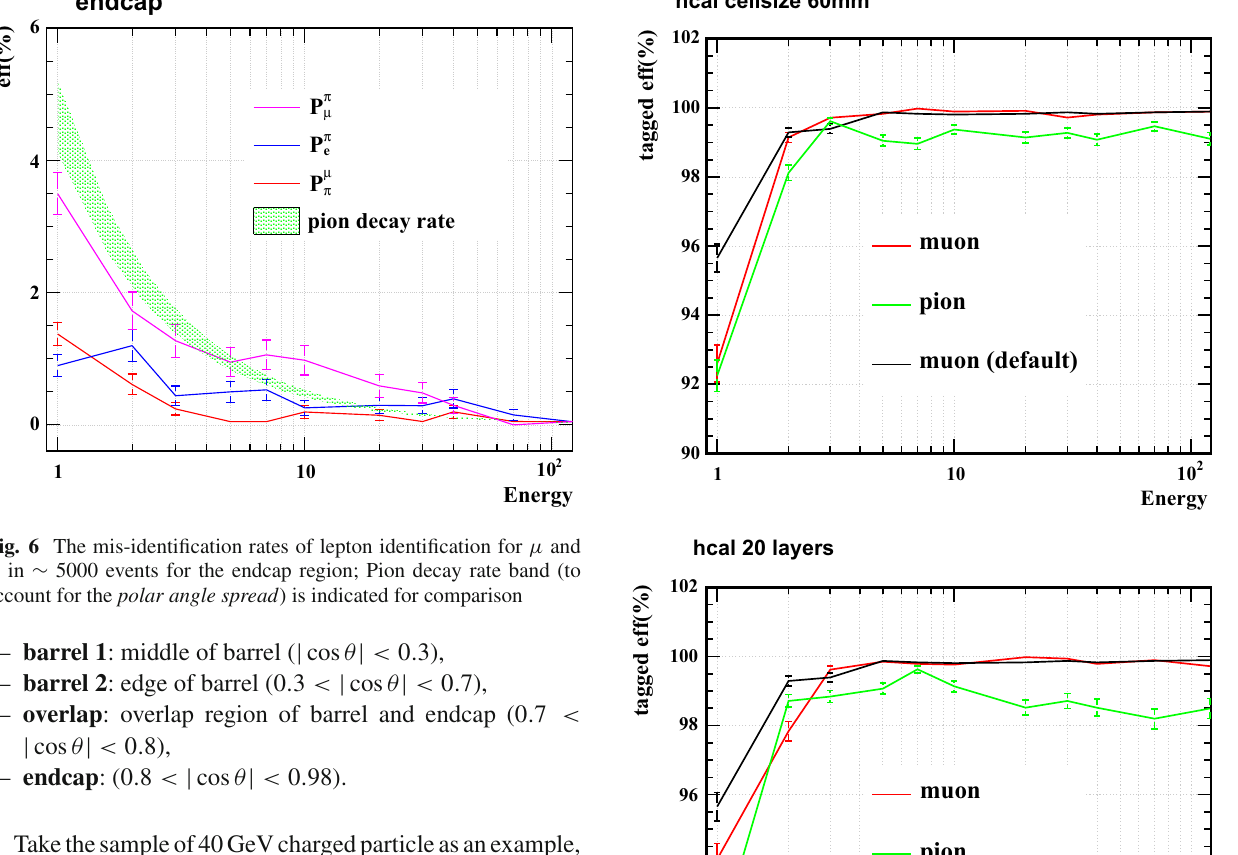
μ , P π μ and P π ) as e